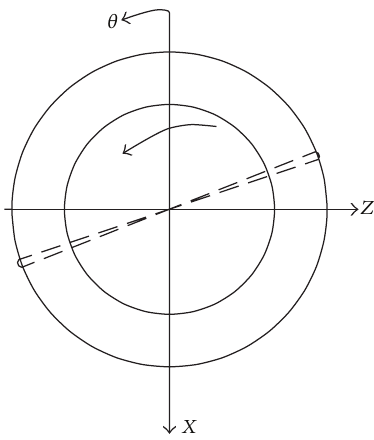
Figure 7: Dn-Up configuration of two-groove oil journal bearing.